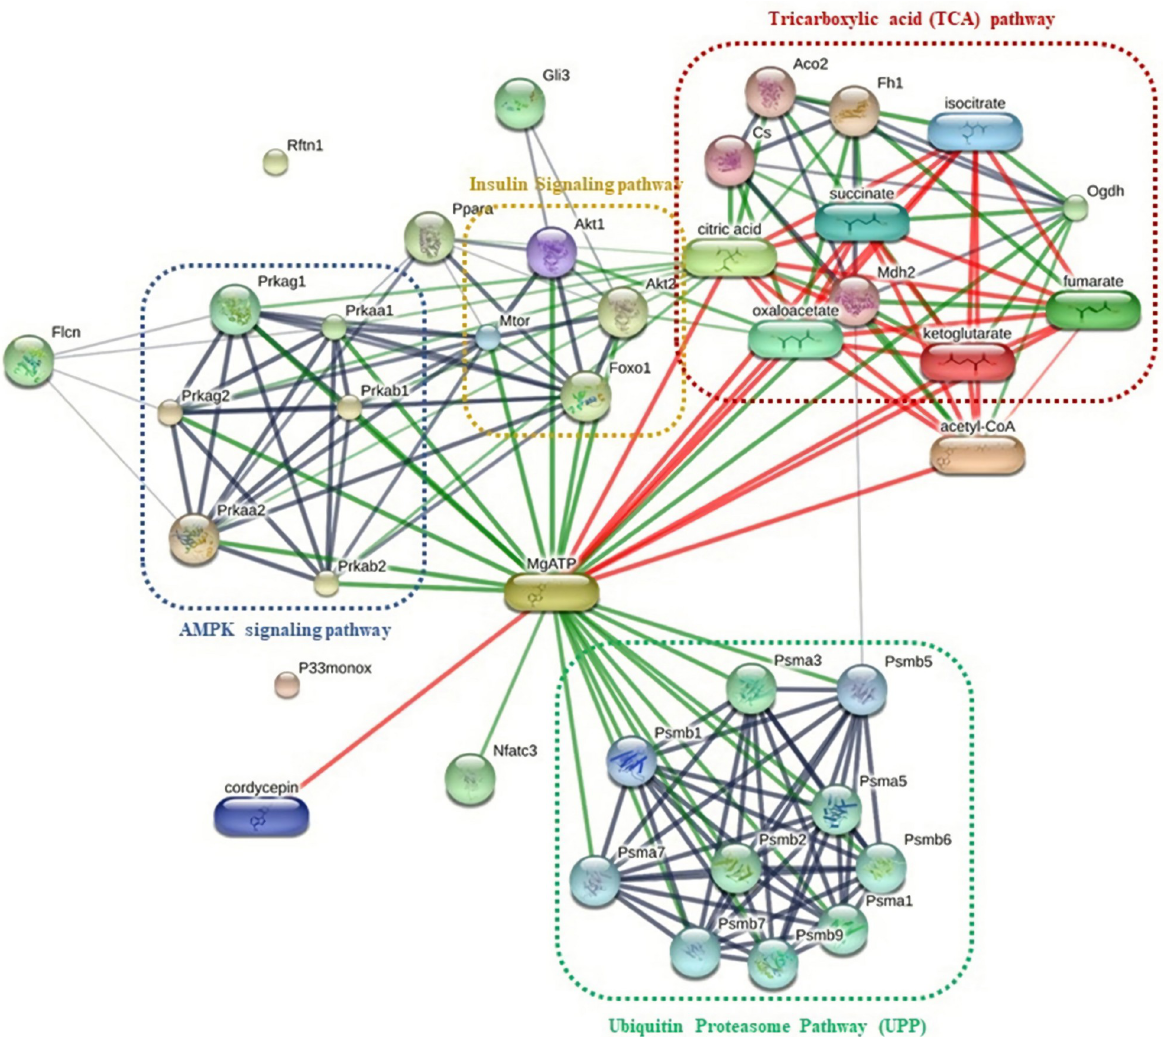
Fig 6. The chemical-protein and protein-protein interaction network of cordycepin and unique proteins from DM+COR and shared protein from N+COR and DM+COR in livers on the hepatic metabolism pathway, analyzed by STITCH v 5.0.